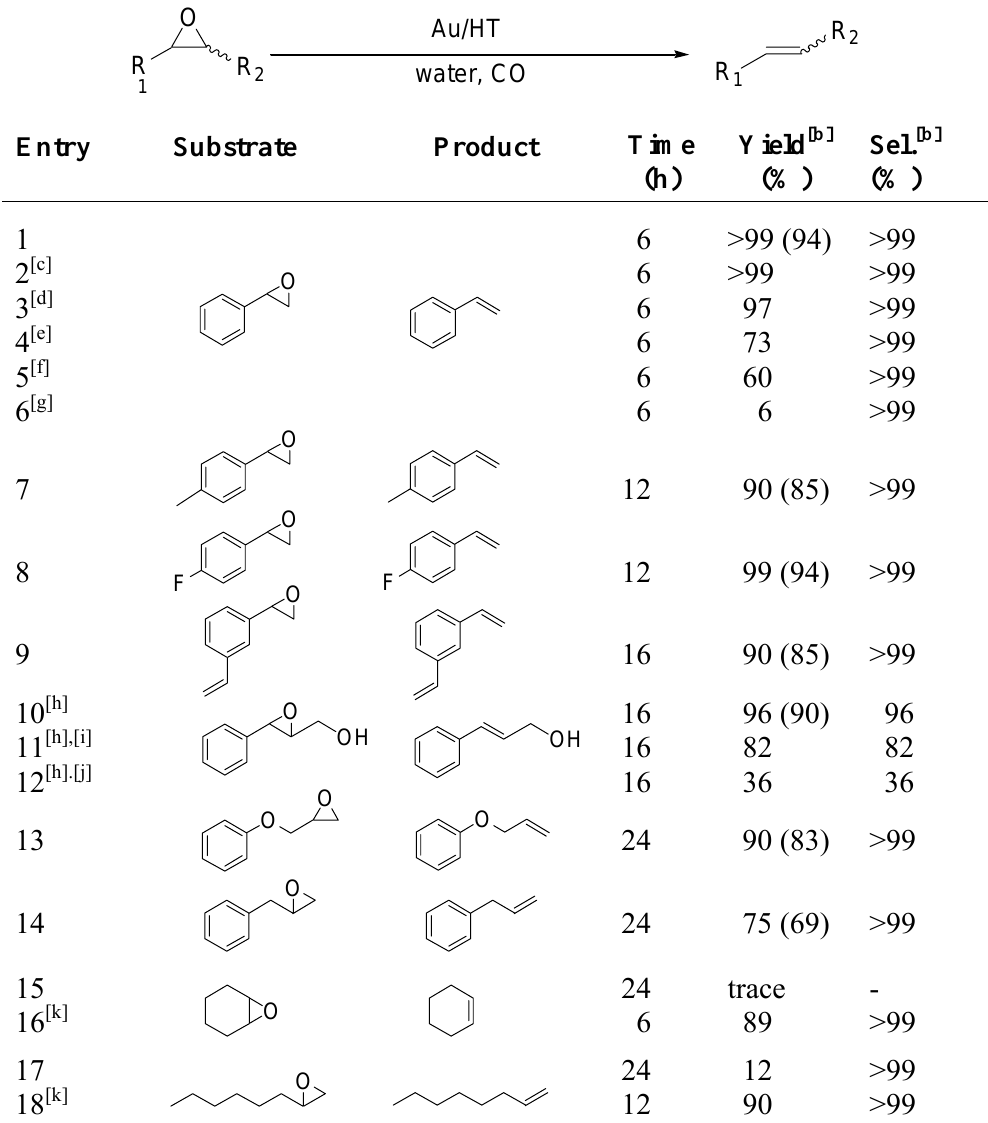
Table 6. Deoxygenation of Various Epoxides in Water Using the Au/HT Catalyst [a]